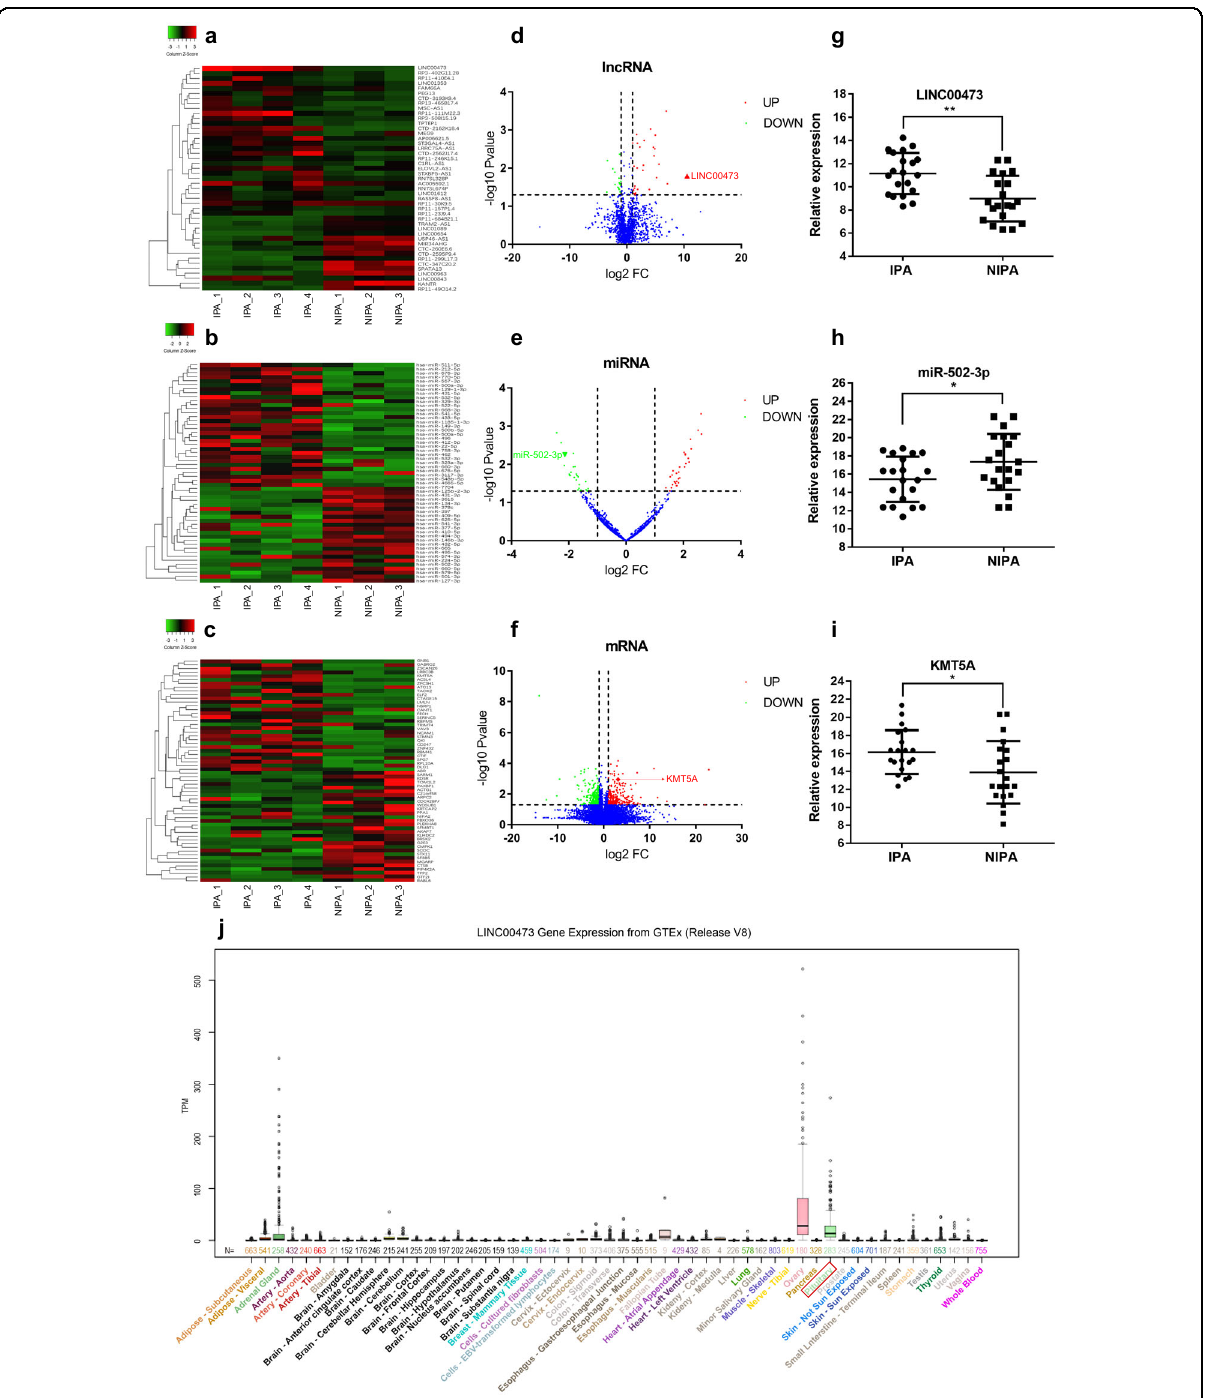
Fig. 2 Characterization of LINC00473 and its corresponding ceRNA network (lncRNA-miRNA-mRNA) in IPA. a – c Heat map showing the DE lncRNAs, miRNAs, and mRNAs between IPA and NIPA. d – f Volcano plot showing DE lncRNAs, miRNAs, and mRNAs between IPA and NIPA, with red dots indicating upregulation and green dots indicating downregulation. The red positive triangle in ( d ) is displayed as LINC00473, the green inverted triangle in ( e ) is displayed as miR-502-3p, and the red diamond in ( f ) is displayed as KMT5A mRNA. g – i qRT-PCR analysis of the expression of LINC00473, miR-502-3p, and KMT5A mRNA in IPA ( n = 20) and NIPA( n = 20) tissues. j LINC00473 gene expression from GTEx, the red box shows the pituitary. * P < 0.05, ** P < 0.01, data represent the mean ±